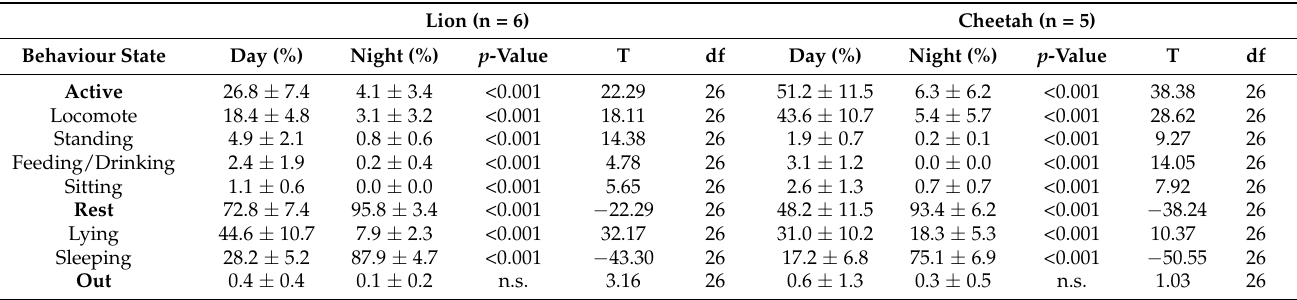
Table 2. Percentages of individual behaviour states of cheetahs and lions during day and night. Differences between day and night were tested for significance (right